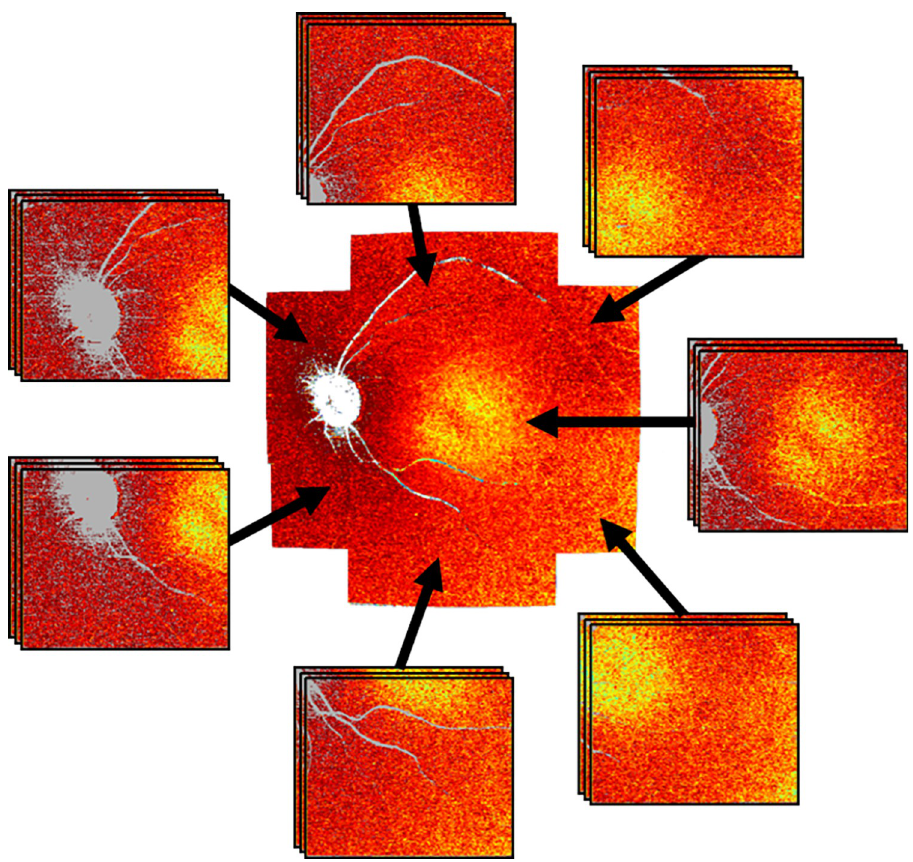
Fig 1. Illustration of the used scanning pattern showing seven distinct imaging positions (sub-fields). Each subject was measured three times each at seven distinct positions. The resulting 21 datasets were combined to a large field, noise reduced